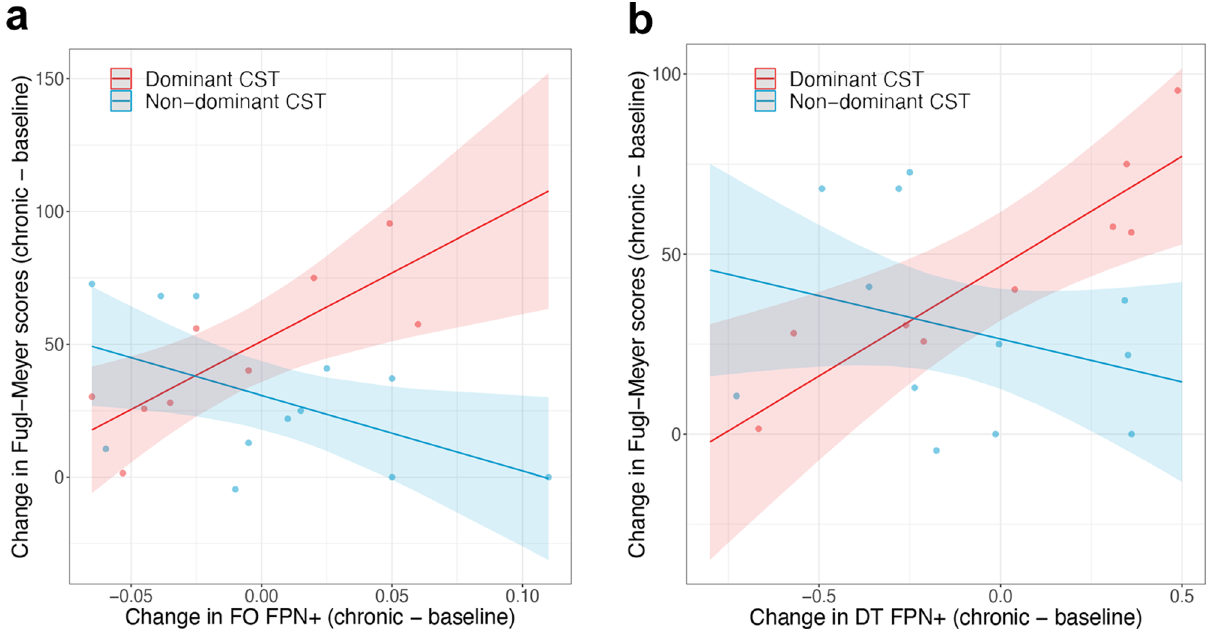
Fig. 5 Results from linear models with N = 21 for each model. Colors indicate the marginal effects plots of change in state metrics within the regression model. Marginal effects plots of the change in Fugl – Meyer scores versus the change in fractional occupancy (FO) ( a ) and dwell time (DT) ( b ) of FPN + from baseline to chronic time points. Shaded bars indicate 95% con fi dence